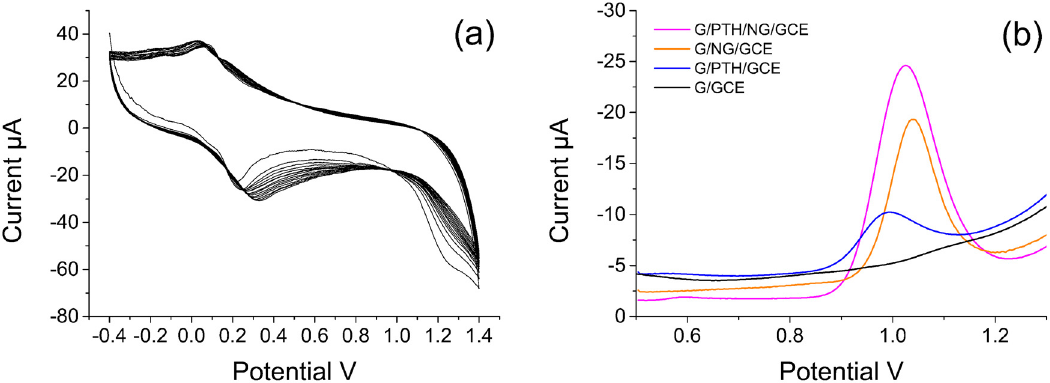
Figure 2: ( a ) The cyclic voltammograms for electrochemical polymerization of PTH on the electrode. ( b ) The oxidation peak current of several modi fi ed electrodes using SWV